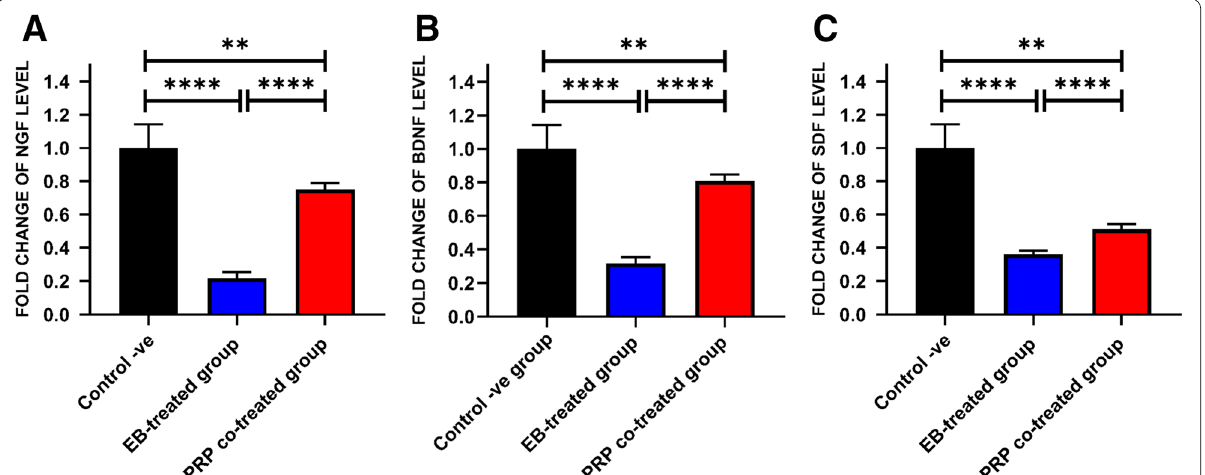
Fig. 9 The relative expression levels of the target genes. A NGF transcript. B BDNF transcript. C SDF transcript. Data were presented as means A significant difference was considered at P <